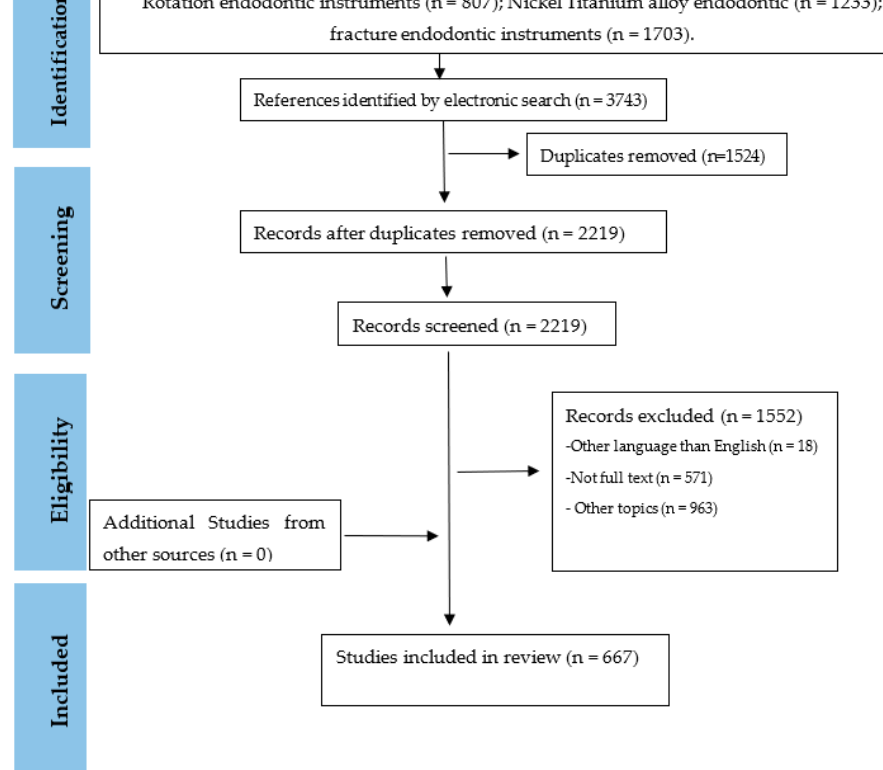
Figure 1. PRISMA flow diagram for review of the literature.